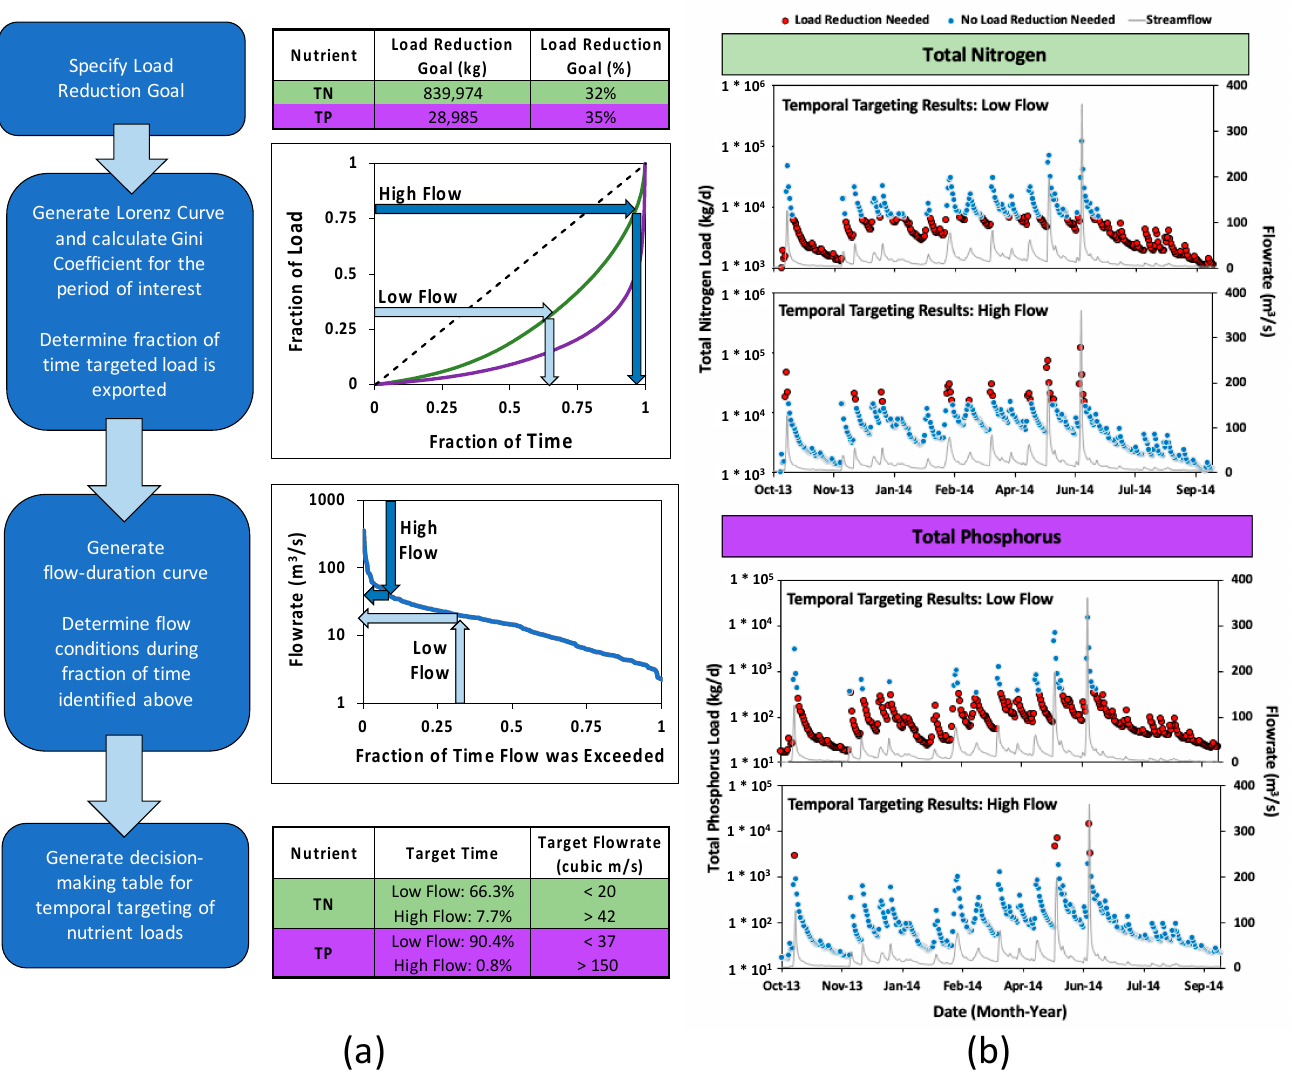
Figure 4. ( a ) Decision-making flow chart demonstrated for Conococheague Creek (2014) to deter- mine site-specific fractions of time during which the targeted loads are exported and identify the corresponding flow conditions; arrows on the Lorenz Curve and flow-duration curve are shown for targeting total nitrogen (TN) load. ( b ) Time-series graphs highlight specific events during which targeted loads for TN and total phosphorus (TP) are exported during low- and high-flow conditions.